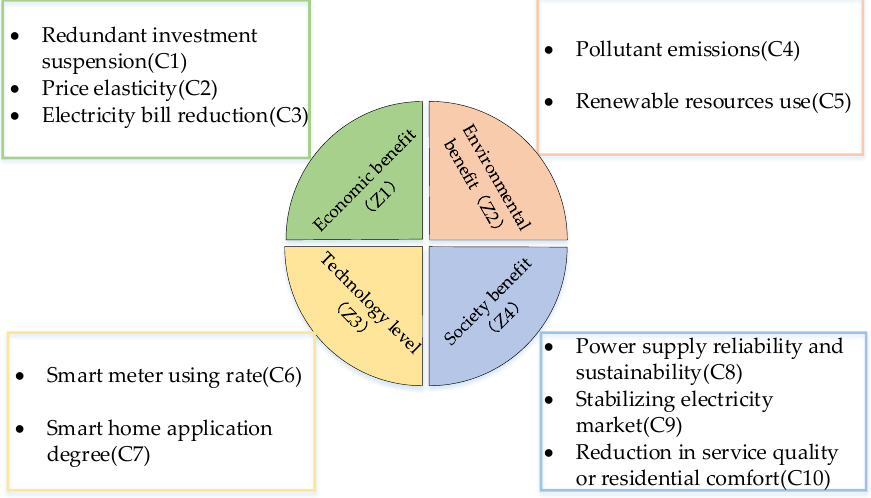
Figure 3. Comprehensive criteria for residential DR performance evaluation .